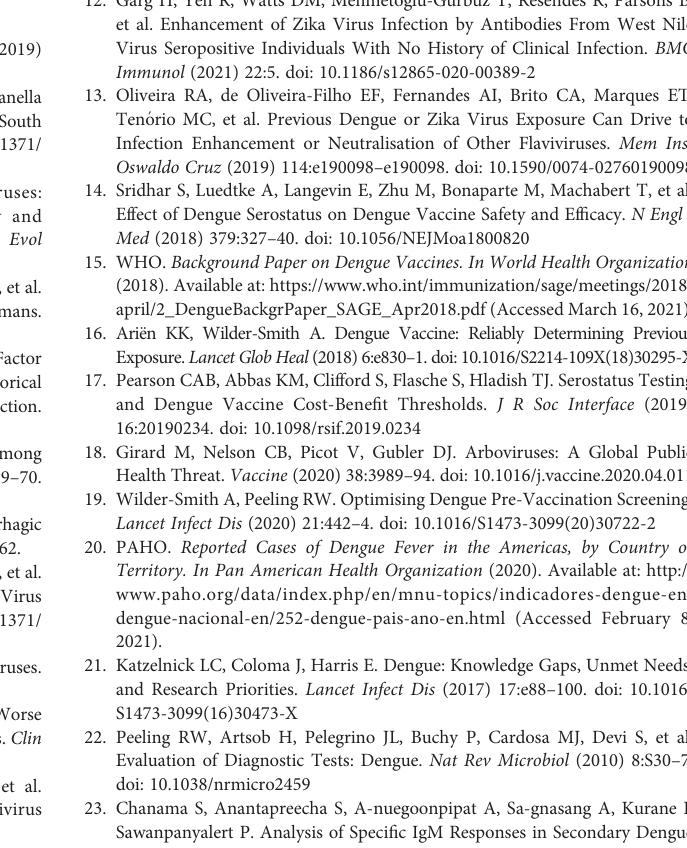
Supplementary Figure9 | Reactive epitopes from NS3 and NS5 proteins among DENV, ZIKV and YFV fl aviviruses. 15-mer peptides from DENV1-4, ZIKV and YFV targeted by IgG (A) and IgM (B) recognized by >5 endemic patients (or > two traveler patients) are indicated by horizontal colored lines. Proteomic coordinates and protein domains percentage identities are as in Supplementary Figure 8. T1: acute, T2: early convalescent, T3: mid convalescent and T4: late convalescent (orange dots) samples. Supplementary Figure 10 | Reactive epitopes from C, prM, NS2A, NS2B, NS4A and NS4B proteins among DENV, ZIKV and YFV fl aviviruses. 15-mer peptides from DENV1-4,ZIKVandYFVtargetedbyIgG (A) andIgM (B) recognizedby>5endemic patients (or > two traveler patients) are indicated by horizontal colored lines. Proteomic coordinates and protein domains percentage identities are as in Supplementary Figure S8 . T1: acute, T2: early convalescent, T3: mid convalescent and T4: late convalescent (orange dots) samples. Supplementary Figure 11 | Identi fi cation of DENV speci fi c and fl avivirus broadly immunogenic epitopes in NS3 and NS5 proteins. IgM and IgG targeted epitopes at the NS3 (A) and NS5 (B) proteins from DENV, ZIKV and YFV viruses, recognized by DENV patients were fi ltered out and mapped to the proteomic coordinates of DENV (Uniprot ref: P33478). Colored bars from light-yellow to orange represent immunodominant regions belonging to one DENV serotype. Red bars represent immunodominant regions belonging to more than one serotype here called PanDENV. Green bars represent immunodominant regions belonging to DENV and ZIKV or/and YFV here called PanFlavi. For both panels the protein domains and the percentage identities are as in Supplementary Figure S8 . Red and green arrows are DENV-speci fi c and PanFlavi peptides, respectively, which Abs responses are further detailed in Supplementary Figure S13 .